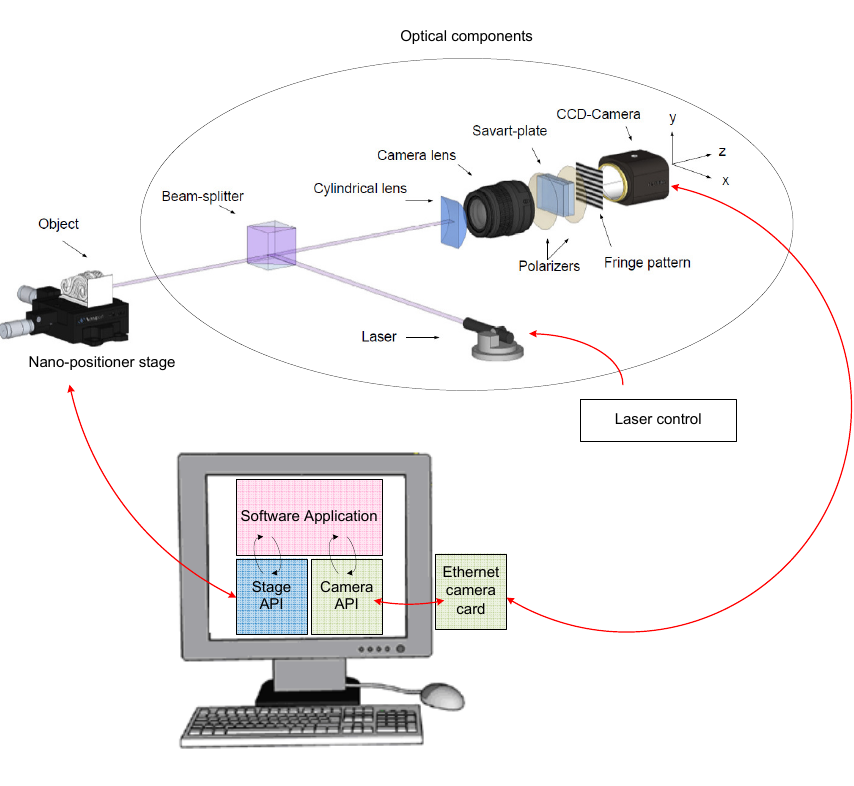
Figure 1. General setup of the prototype